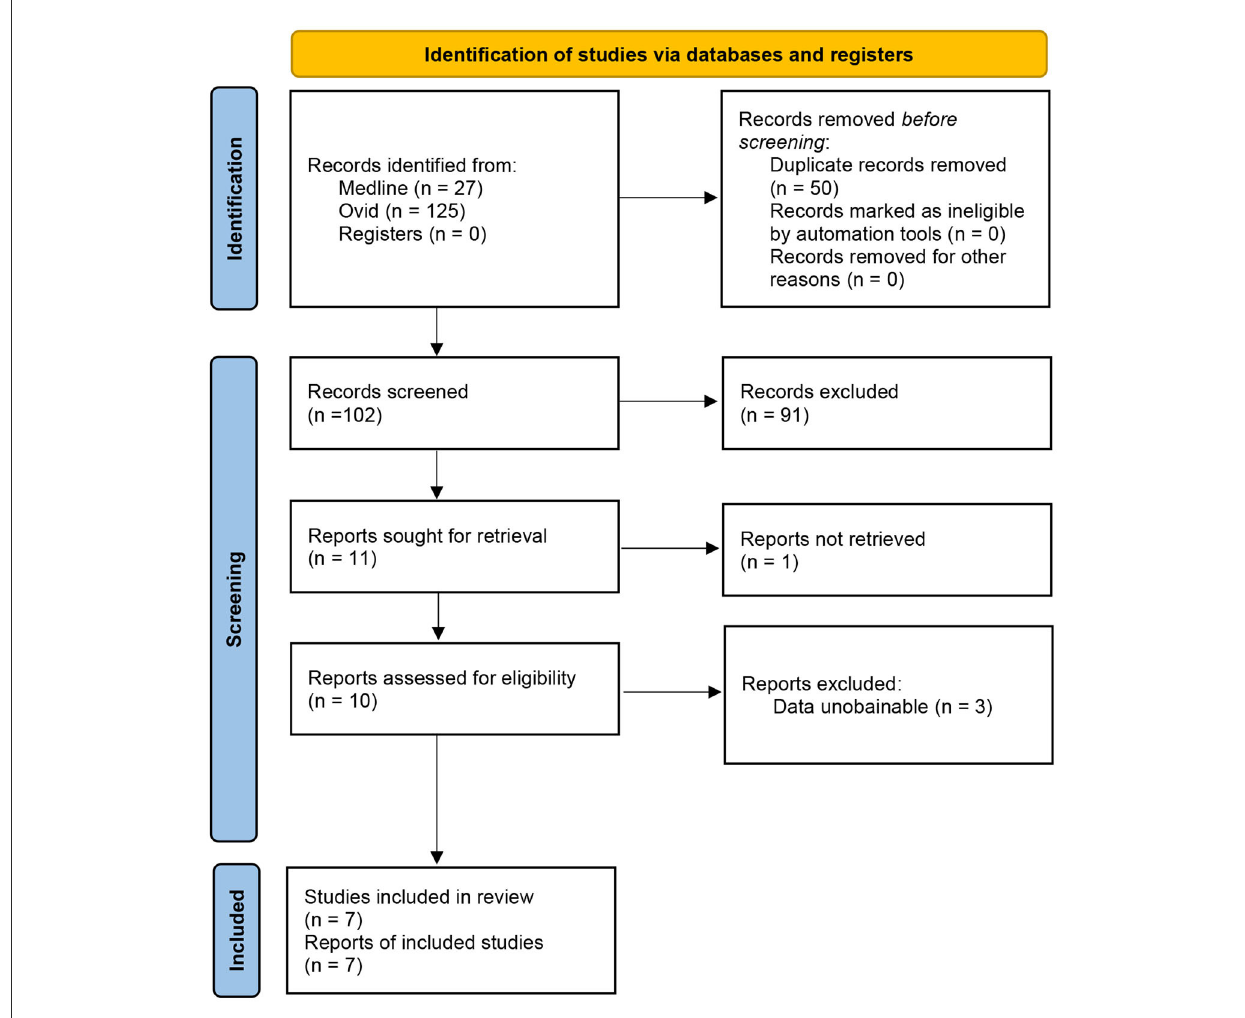
FIGURE1 A flowchart of the literature